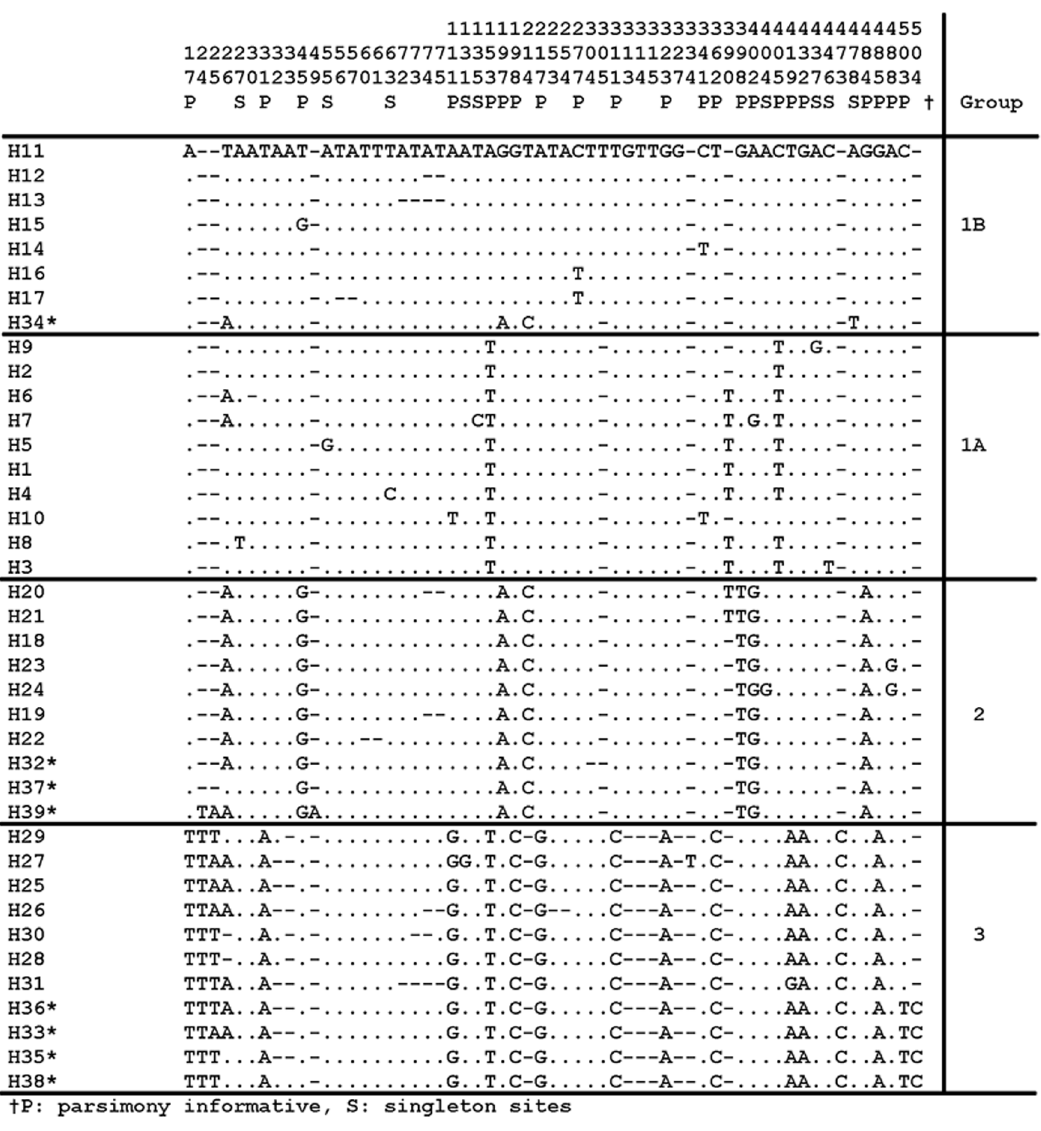
Figure 1. Haplotype sequence differences found in all 190 Triatoma dimidiata ITS2 sequences (39 haplotypes). Haplotypes are separated into the 4 ITS2 groups described in the text. Nucleotide positions are given (read vertically) at the top based on Clustal W alignment. ‘‘.’’=identity, { S-singleton sites, P-parsimony informative sites, *newly identified haplotypes.